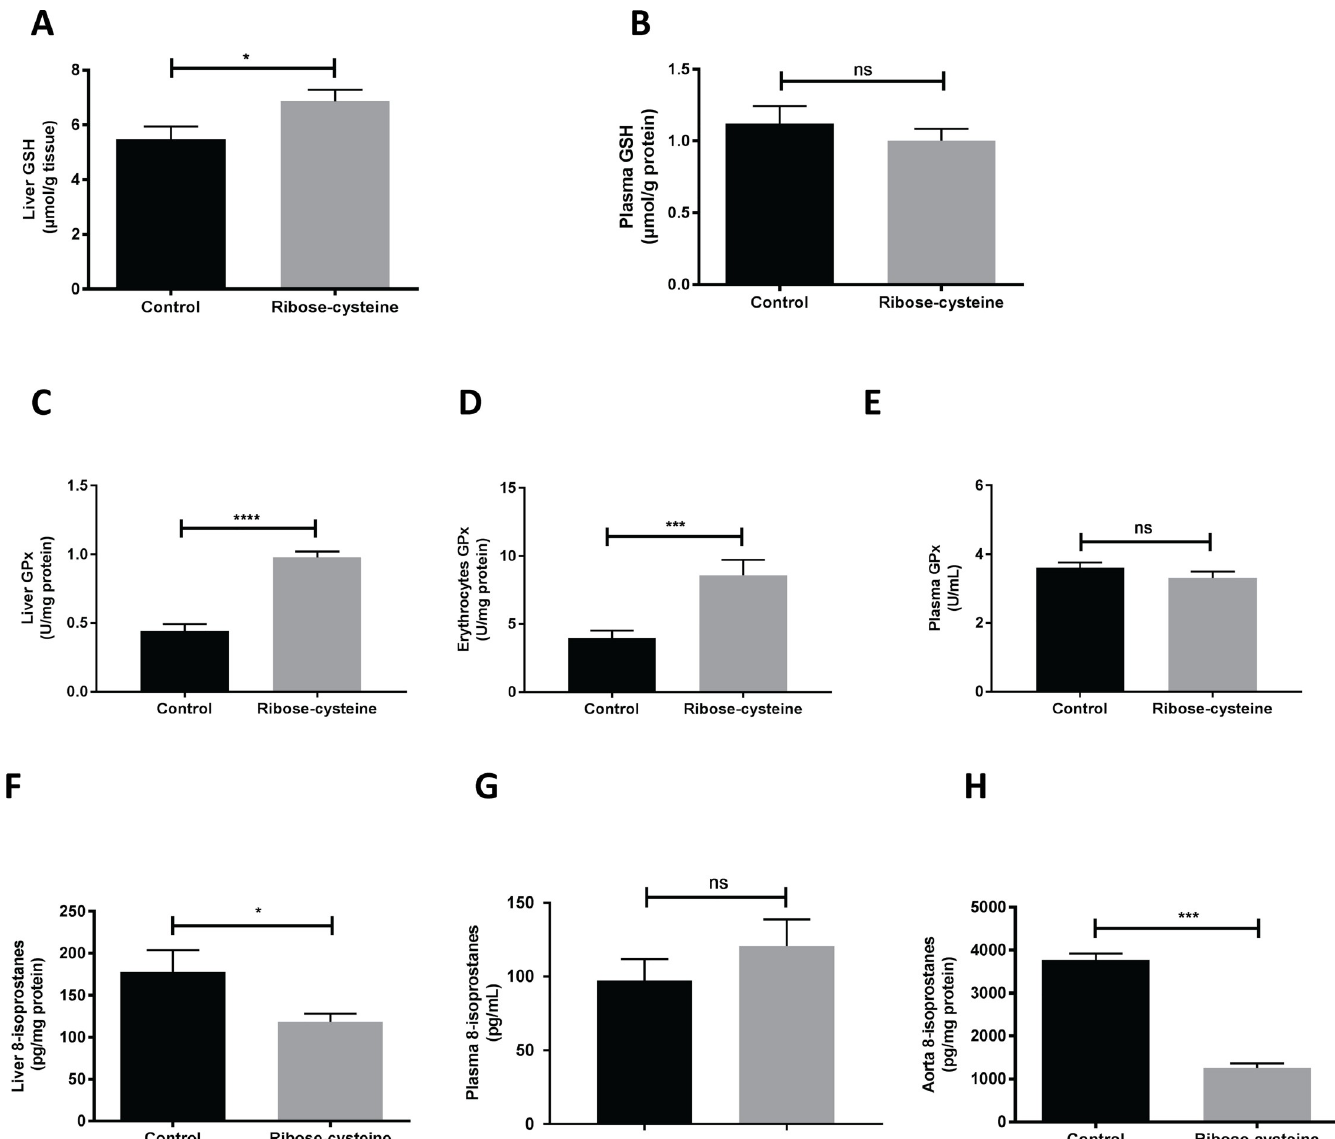
Fig 2. Ribose-cysteine increases liver GSH and GPx activity and decreases total 8-isoprostanes in liver and aortae of apoE-/- mice. ApoE-/- (12-week old) were treated with 4–5 mg/day ribose-cysteine in their drinking water for 8 weeks with control apoE-/- mice given normal drinking water (n = 15 per group). The GSH content of tissues and plasma was measured by LC-MS. The GPx activity in liver, erythrocytes and plasma was measured by spectrophotometric assay. Total 8-isoprostanes in liver, aortae and plasma were measured by an 8-isoprostane EIA kit. (A) Liver GSH (n = 15), (B) Plasma GSH (n = 15), (C) Liver GPx activity (n = 15), (D) Erythrocyte GPx activity (n = 15), (E) Plasma GPx activity (n = 15), (F) Total 8-isoprostane in the liver (n = 15), (G) Free 8-isoprostanes in the plasma (n = 15), (H) Total 8-isoprostane in a sample of 5 pooled arteries analysed in triplicate. � p < 0.05, ��� p < 0.001, ���� p < 0.0001, ns; not significant. Error bars indicate means ±